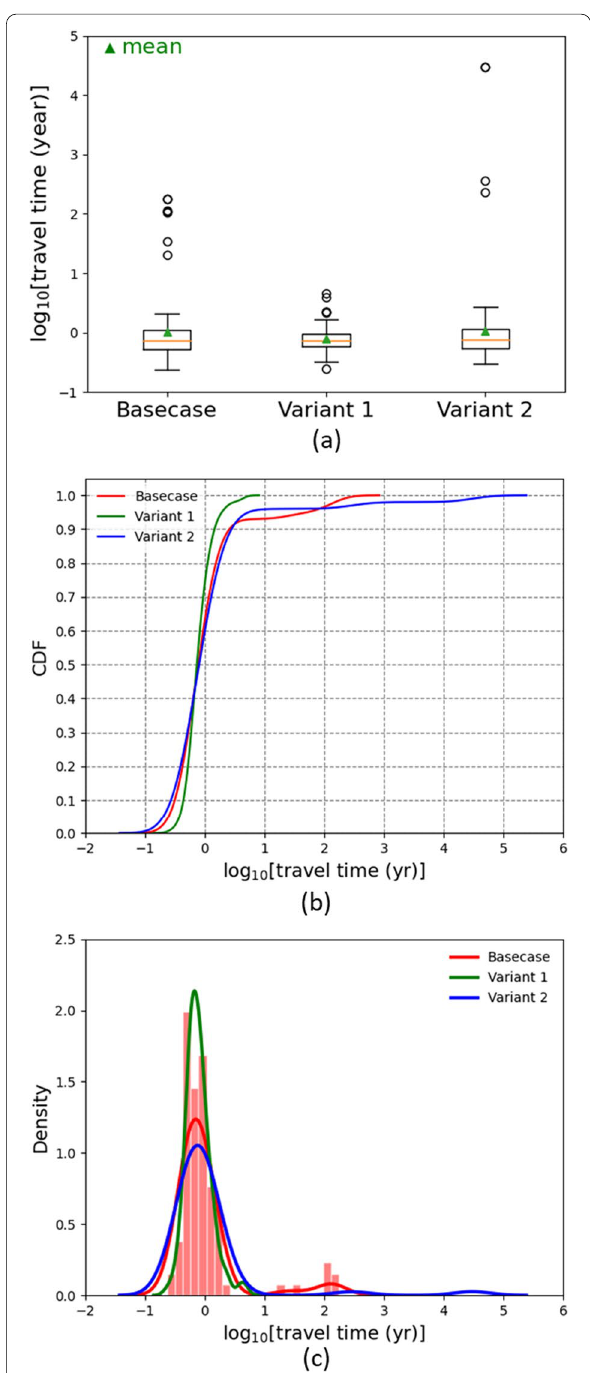
Fig. 11 Statistical plots of the travel time for the three cases considered in this paper, including, from top to bottom, boxplot, breakthrough curve, and histogram with best‑fit